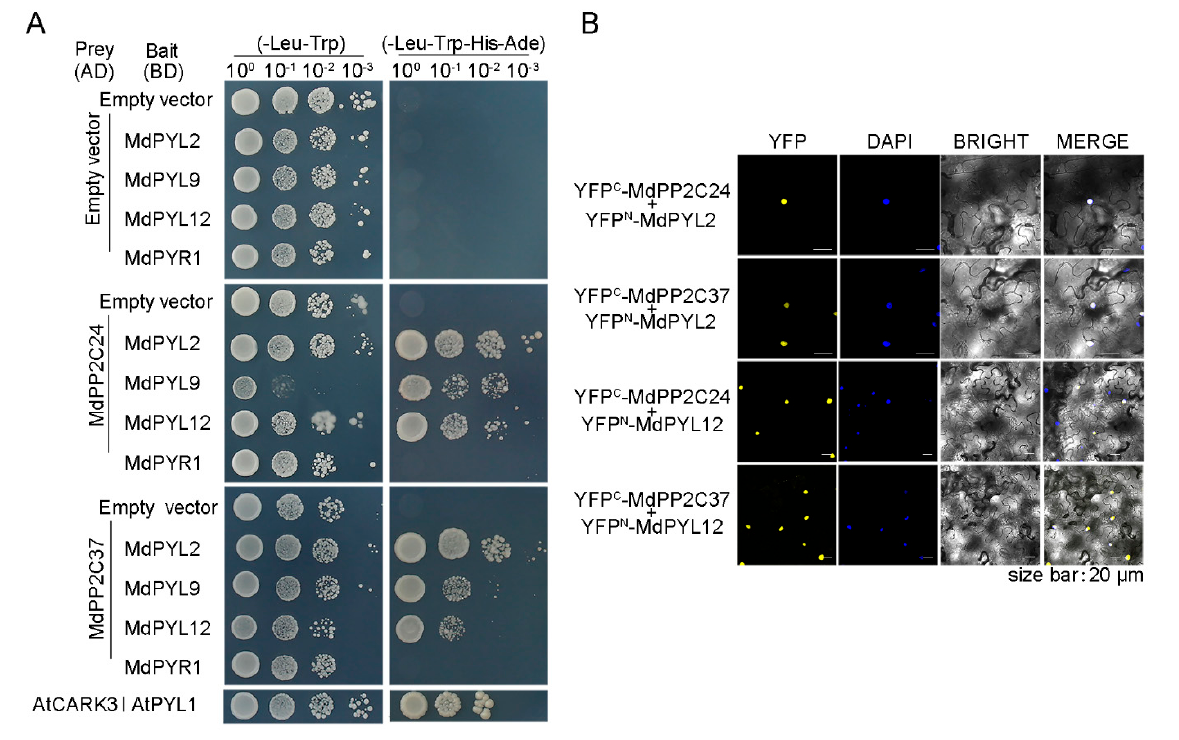
Figure 6. MdPP2C24/37 interacted with MdPYL2/12 in vitro and vivo. ( A ) MdPP2C24/37 interacted with MdPYL2/9/12 in the yeast two-hybrid assay. AD–MdPP2C24/37 fusion prey vectors were co- transformed with BD–MdPYL2/9/12/PYR1 fusion bait vectors into yeast cells. Positive interactions were indicated by the ability of cells to grow on SD/ − Leu/ − Trp/ − His/ − Ade dropout medium. Empty AD prey vector and BD bait vectors were used as negative controls. ( B ) MdPP2C24/37 interacted with MdPYL2/12 in the bimolecular fluorescence complementation (BiFC) assay, showing fluores- cence in nuclei of tobacco leaf epidermal cells. The C-terminus part of YFP was fused to MdPP2C24/37, and the N-terminus part of YFP was fused to MdPYL2/12. All experiments were replicated three times, with the same results obtained.